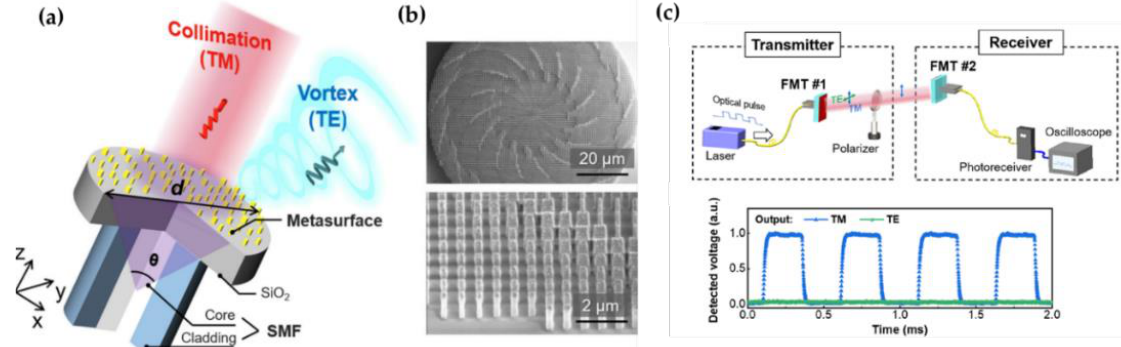
Figure 12. ( a ) Schematic of bifunctional optical fiber meta-tip. ( b ) SEM images of the metasurface and the zoomed-in nanobricks. ( c ) Demonstration of polarization-controlled data transmission with a pair of fiber meta-tips and the transmitted output signals with TE/TM polarization states. Reprinted with permission from Ref. [85]. Copyright 2021 Wiley-VCH. Coincidentally, the practical use of fiber-integrated metasurface-based in the field of fiber communication networks has been further emphasized in [86]. The metasurface consists of 70-nm-thick gold film perforated with an array of asymmetrically split ring apertures (Figure 13a), which can be placed either the anti-nodes (coherent absorption) or nodes (coherent transparency) to flexibly control the optical absorption of incident light from 0 to 100% (Figure 13b).